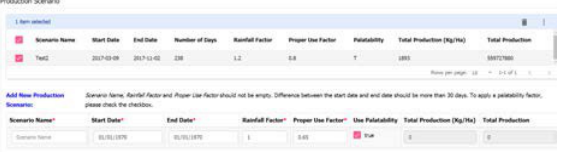
Figure 7. Example of one of the scenario